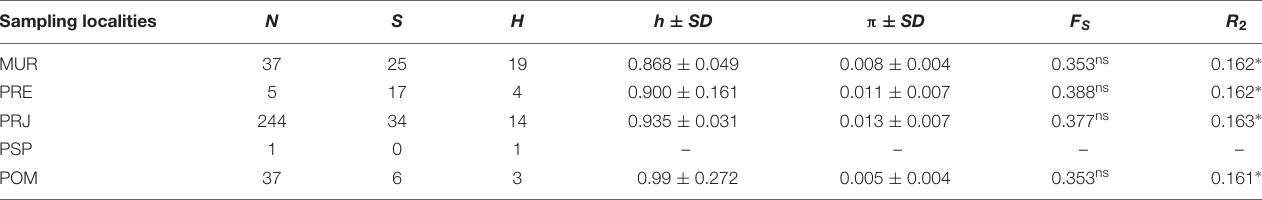
TABLE 3 | Mitochondrial DNA sampling and descriptive statistics for Steindachneridion parahybae . Sampling localities